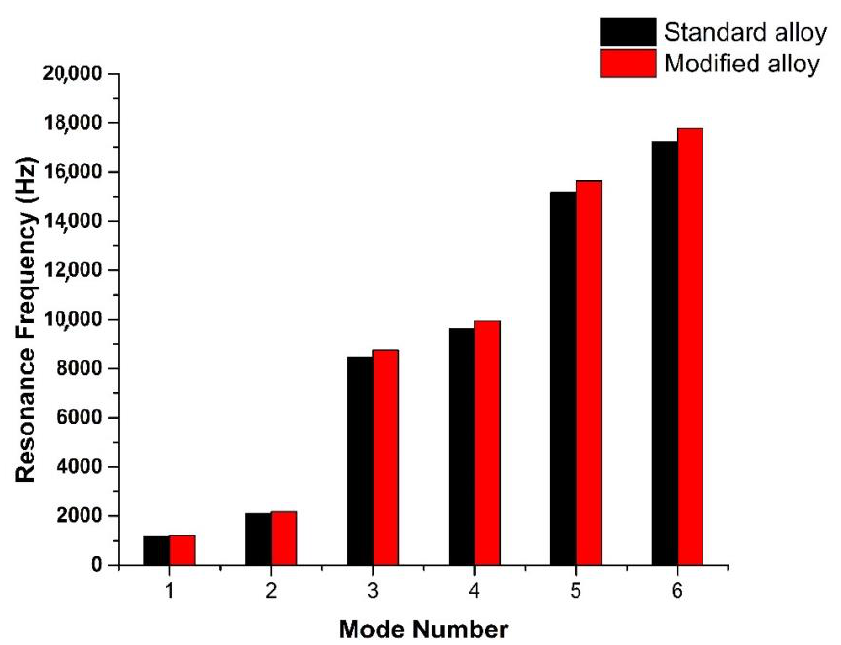
Figure 11. ( a ) First mode shape; ( b ) second mode shape; ( c ) third mode shape simulation analysis of the standard Al-2.5% Mg alloy; and ( d ) simulation of modal analysis for the studied alloys using FRF representation.